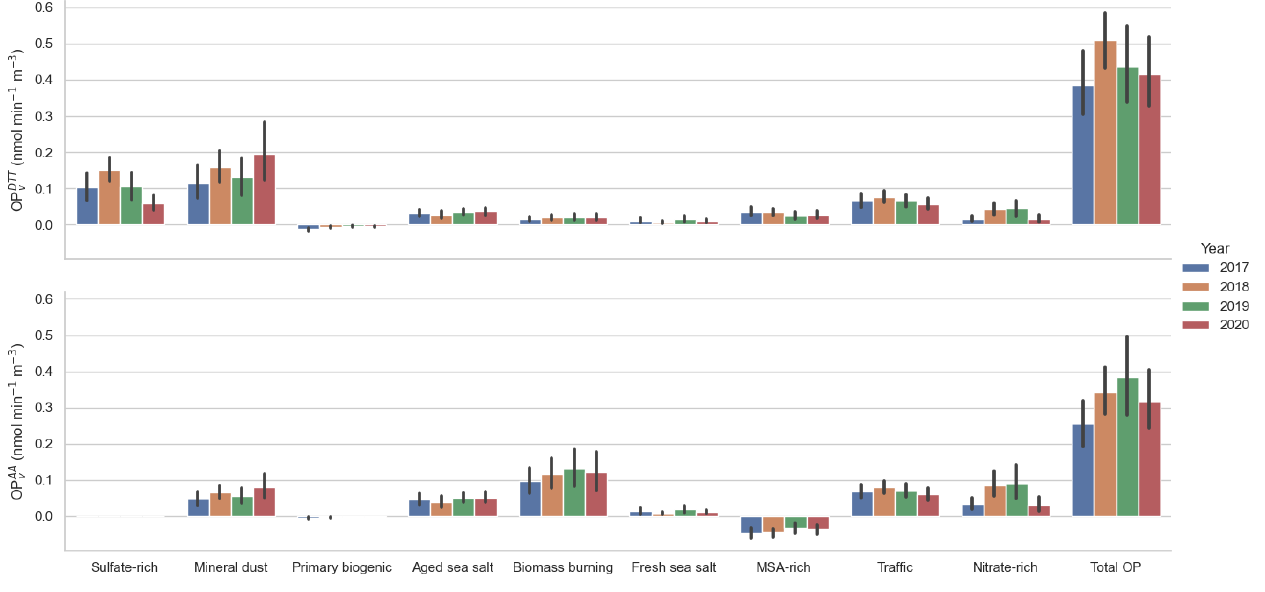
Figure 12. Yearly average contributions of sources to OP activity in nmolmin − 1 m − 3 (OP DTT v and OP AA v ) from the year 2017 to 2020 at the OPE site. Note that total OP is the sum of OP contributions of all sources as modelled by the MLR